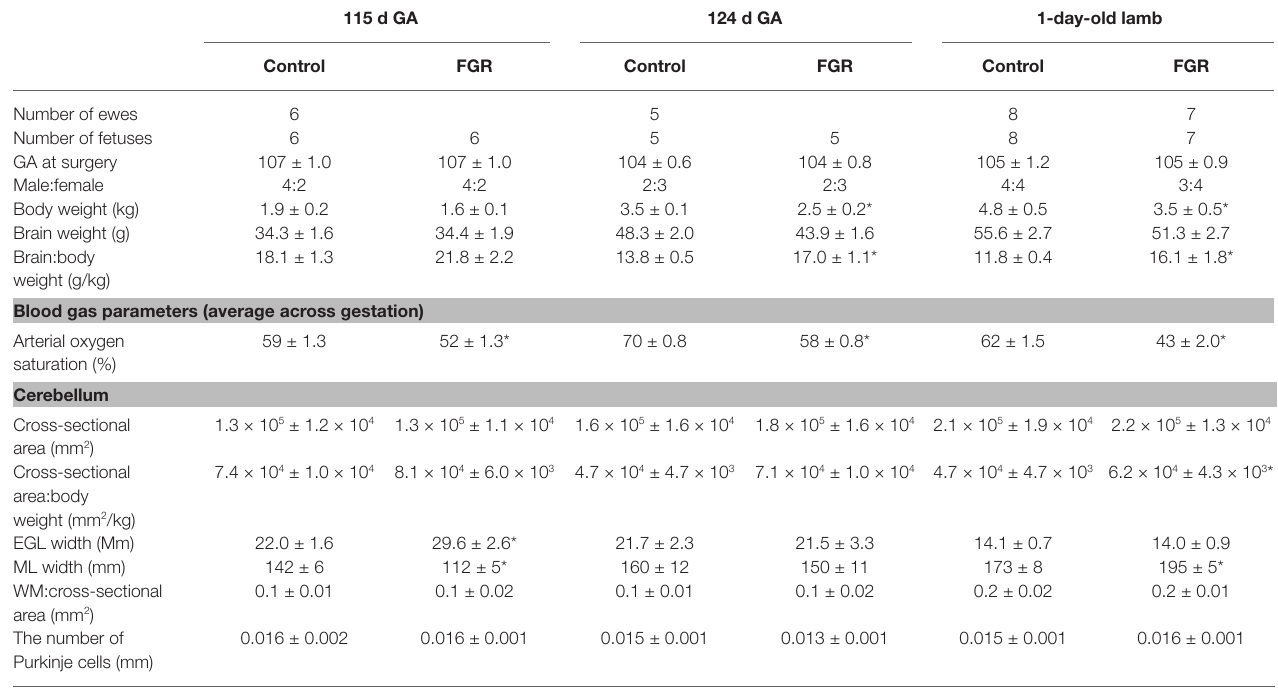
TABLE 1 | Fetal and neonatal outcomes. 115 d GA 124 d GA 1-day-old lamb Control FGR Control FGR